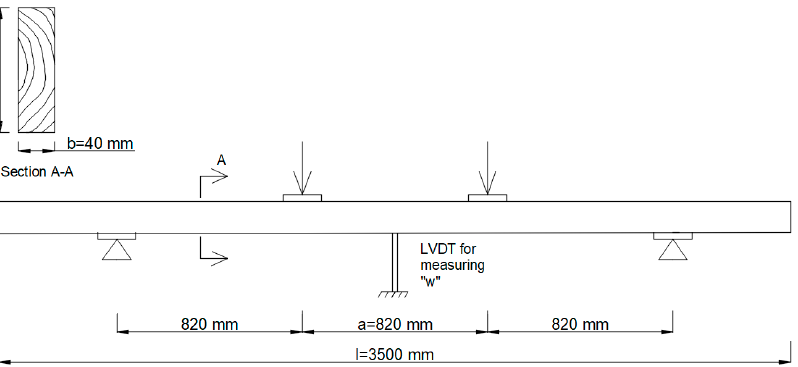
Figure 2. Static diagram of a four-point structural timber bending test to determine MOE and MOR, where LVDT—linear variable differential transformer, w—deflection.